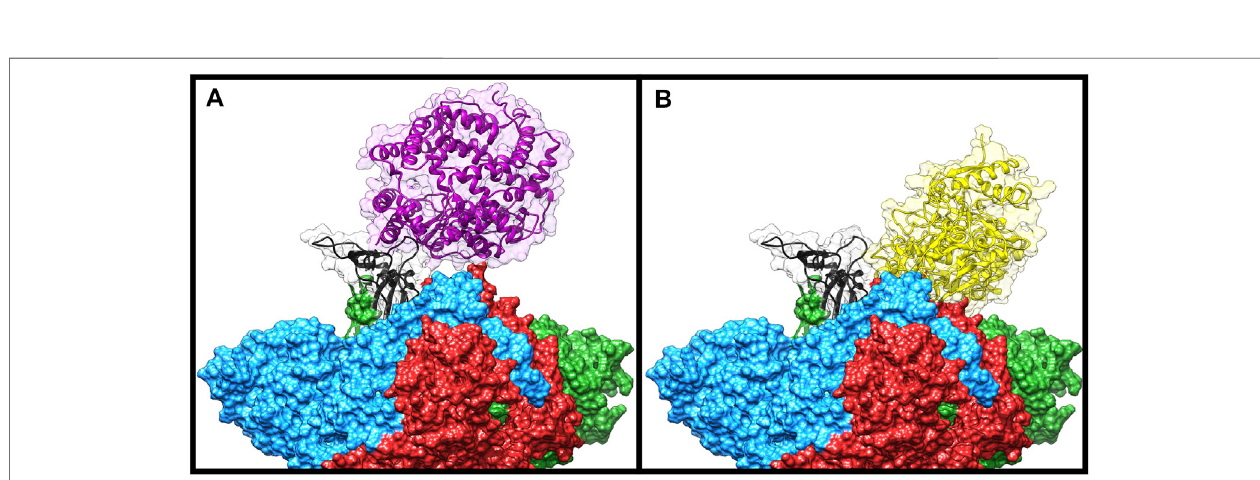
FIGURE 4 | Comparison of the Frodock best complex and ACE2-spike glycoprotein (PDB ID: 6LZG). The red, blue, and green solid surfaces represent the three different chains composing the spike glycoprotein. The black ribbons highlight the CTD1 domain in the up conformation. The magenta and yellow ribbons represent the ACE2 (A) and the bovine lactoferrin (B) , respectively, surrounded by a transparent molecular surface representation, in order to point out the positions occupied in the space by the different structures.